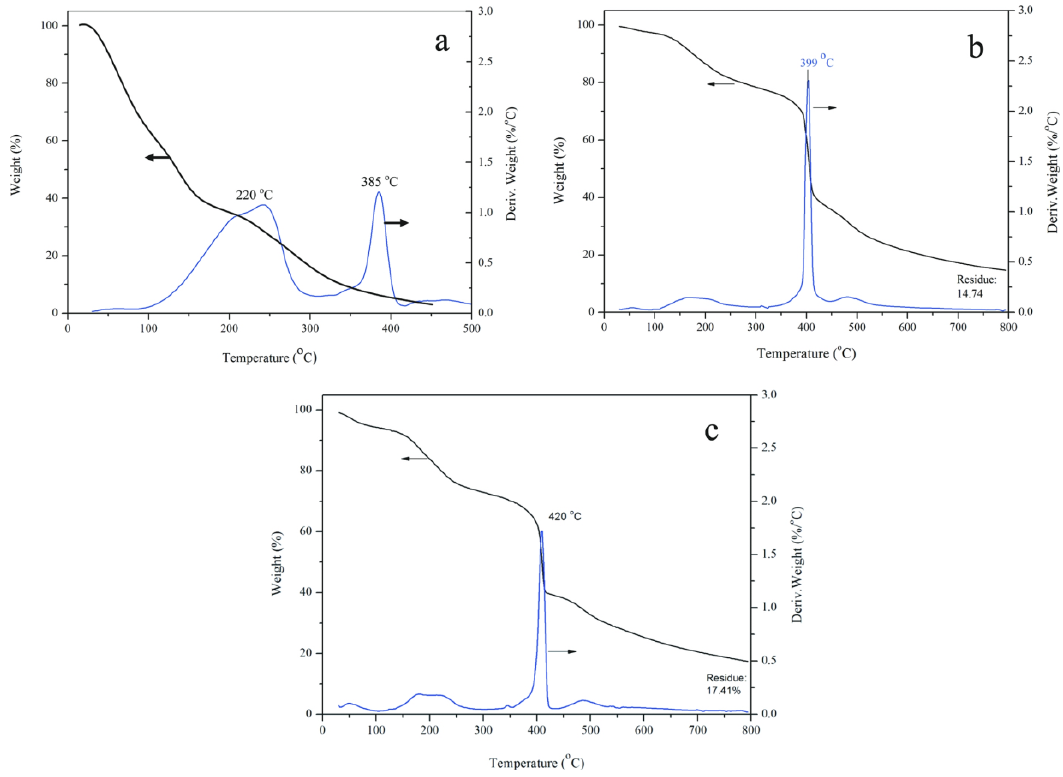
Figure 10. TG/DTG curves of the self-healing microcapsules without graphene, ( a ) MG-0, ( b ) MG-2, and ( c ) MG-6.